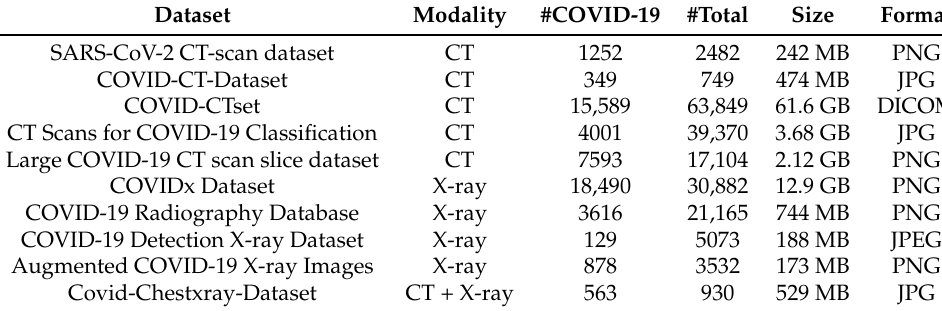
Table 6. Summary of COVID-19 image classification